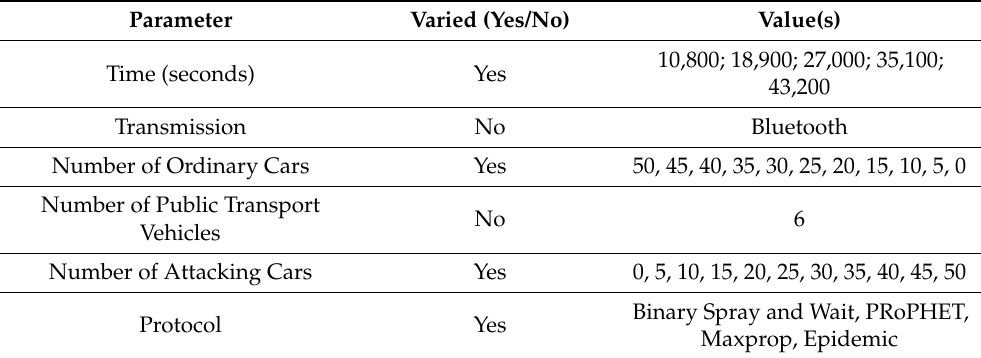
Table 2. Table to show the experiment